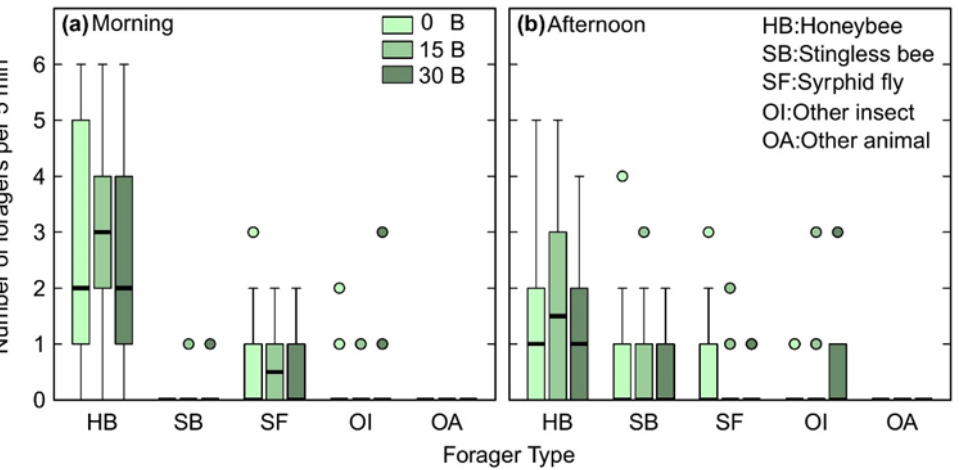
Figure 1. Numbers of flower visitors during 5-min periods in the ( a ) morning and ( b ) afternoon in a 1 m 3 section of Hass avocado trees treated with 0, 15 or 30 g boron (B) per tree prior to anthesis. Medians are presented with 25th and 75th percentiles (boxes), 10th and 90th percentiles (whiskers)